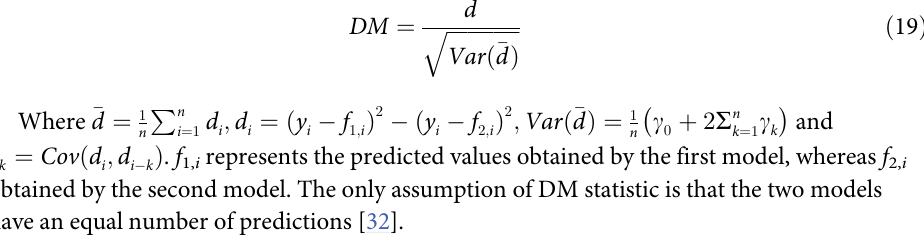
PLOS ONE | https://doi.org/10.1371/journal.pone.0283584 April 13,